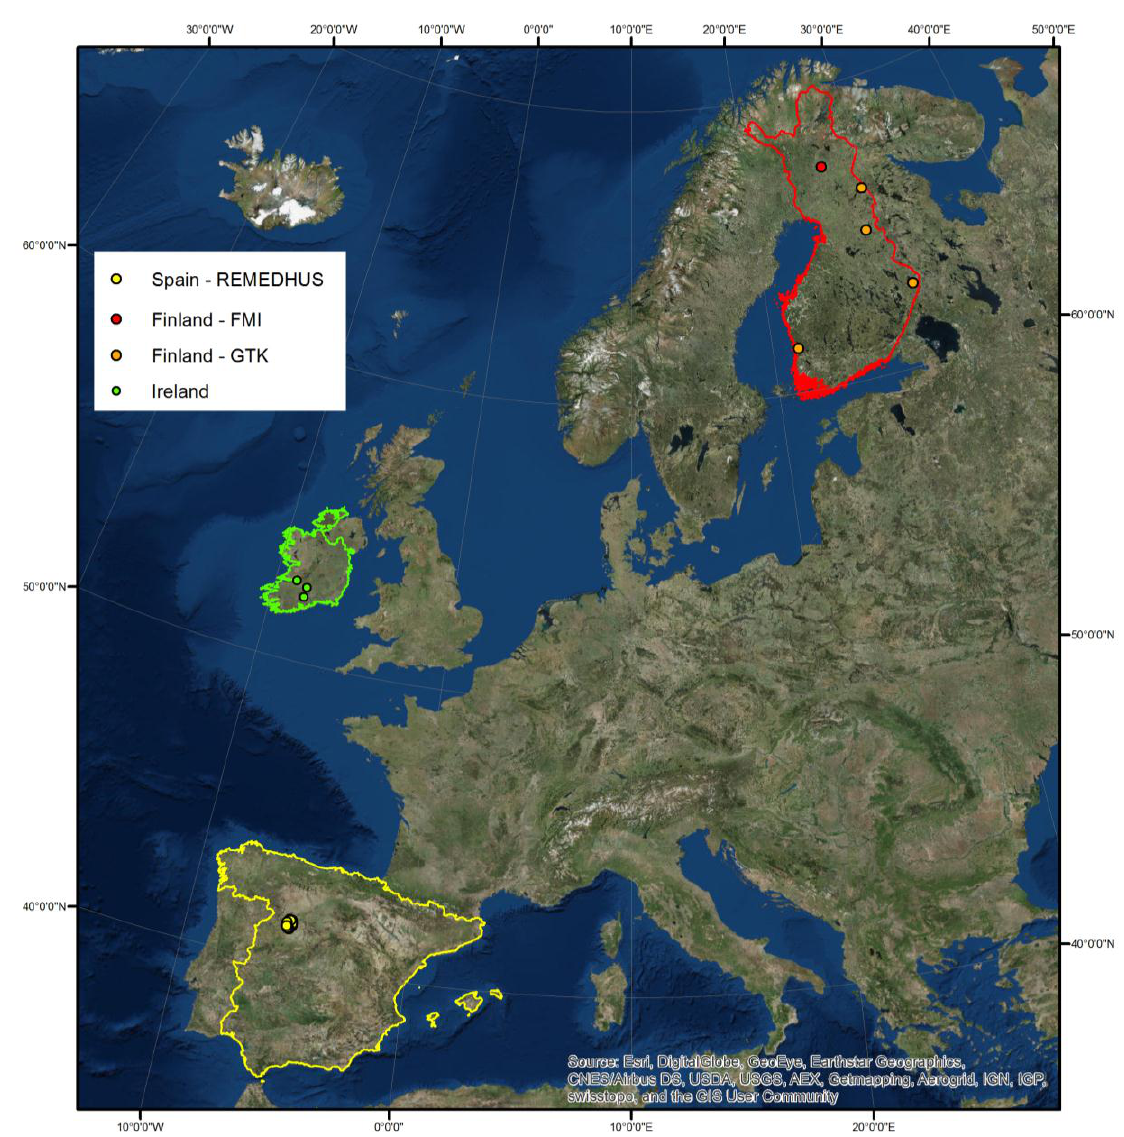
Figure 1. Areas and sites under investigation in Spain (REMEDHUS soil moisture network), Ireland (soil moisture network from AEON project) and Finland (FMI and GTK soil moisture